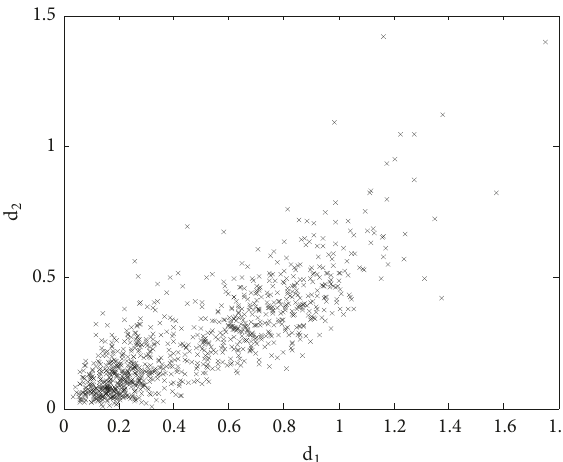
Figure 4: Classification of the K-medoids clustering algorithm with GFV.